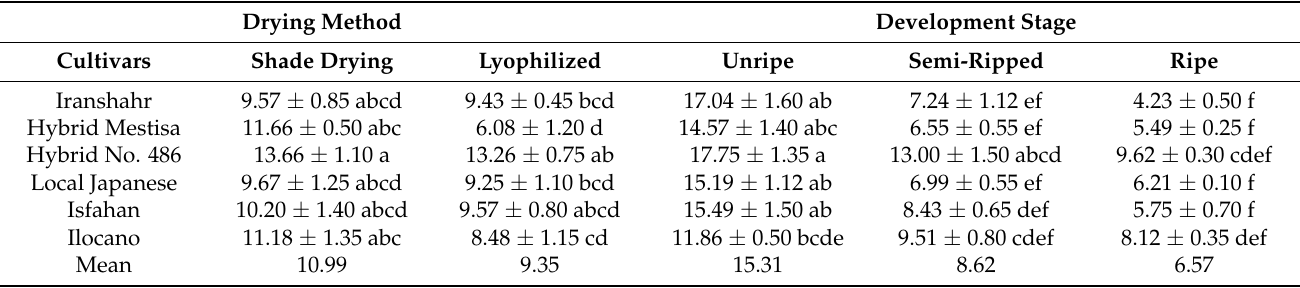
Table 8. Cultivar × drying method and cultivar × development stage interaction effects on fruit flavonoid content (mg